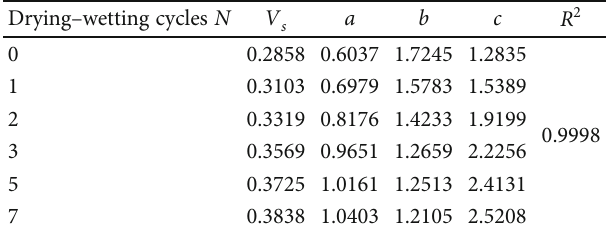
Surface equation: Rational2D function Decisive factor R 2 = 0.9902